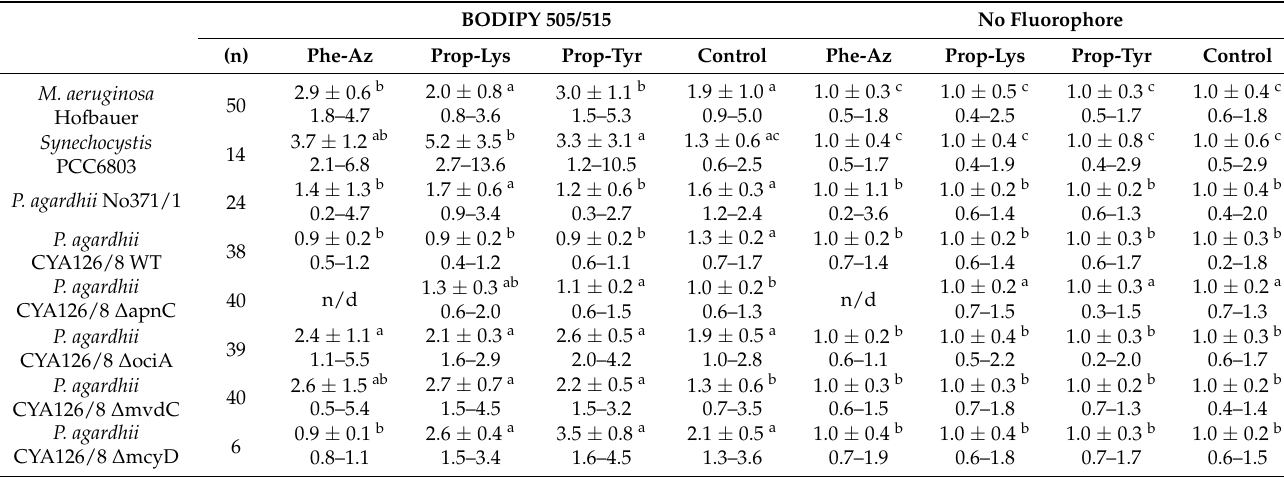
Table 4. Average ( ± SD) min–max green fluorescence intensity obtained for individual treatments using non-natural amino acid feeding (Phe-Az, Prop-Lys, Prop-Tyr) and subsequent labeling by BODIPY. The intensity was divided by the average intensity of control filaments or cells without BODIPY incubation (No Fluorophore). n : number of individual filaments ( Planktothrix ) or cells ( Microcystis , Synechocystis